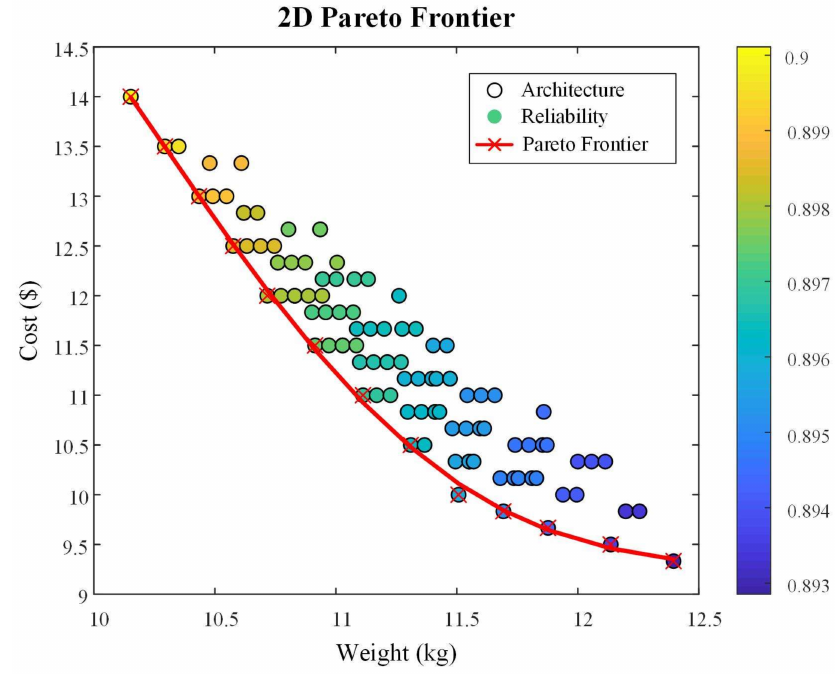
Figure 13. 2D Pareto frontier among weight, cost, and reliability.